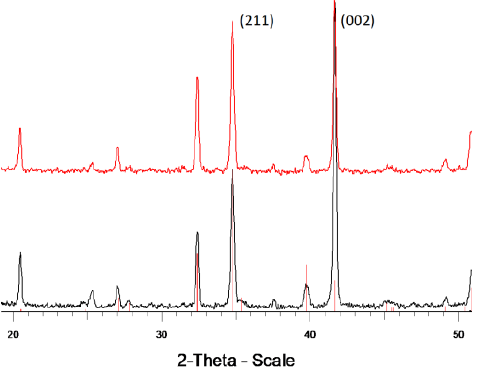
Figure 9. XRD patterns of samples of parent glass C1 heat treated at 850 ◦ C for 5 h (black pattern) and 900 ◦ C for 1 h (red